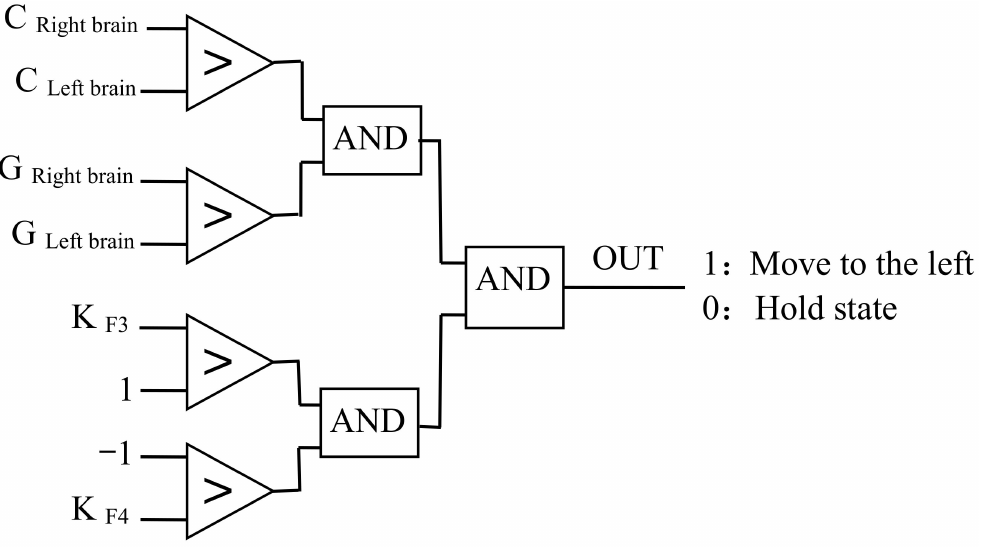
Figure 6. The logic of motion recognition.